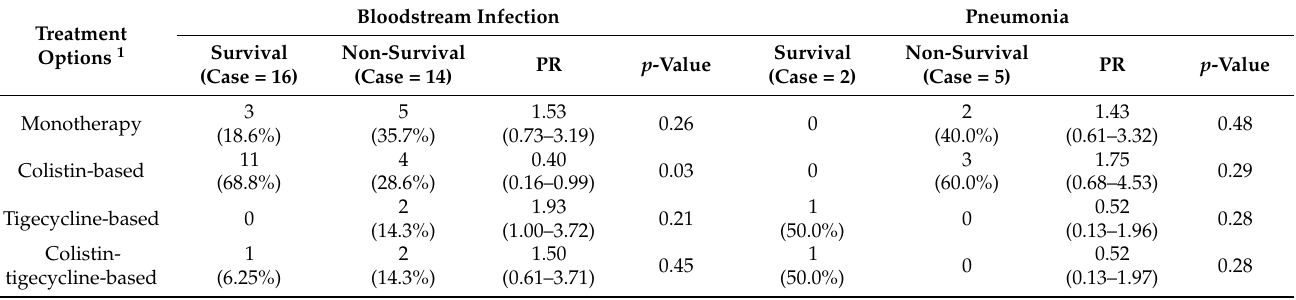
Table 5. Univariate analysis of treatment options associated with 60-day